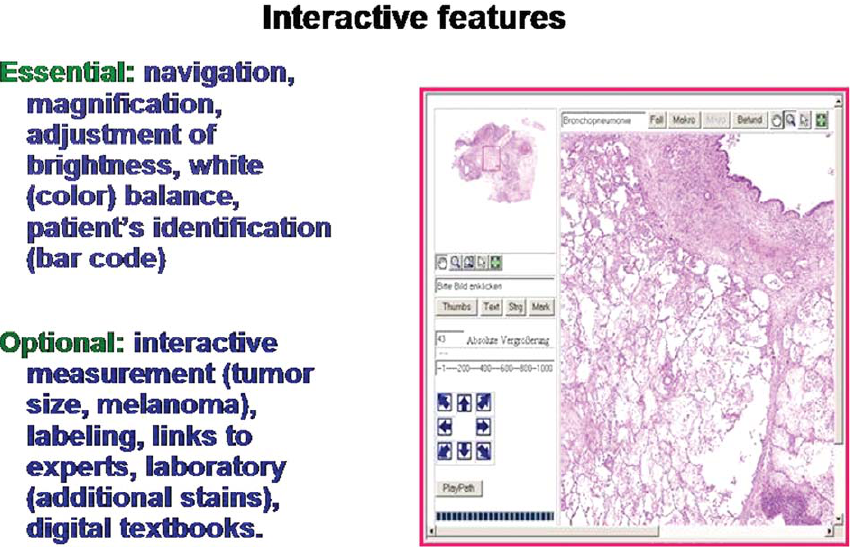
Fig. 3. Essential and optional interactive features in a